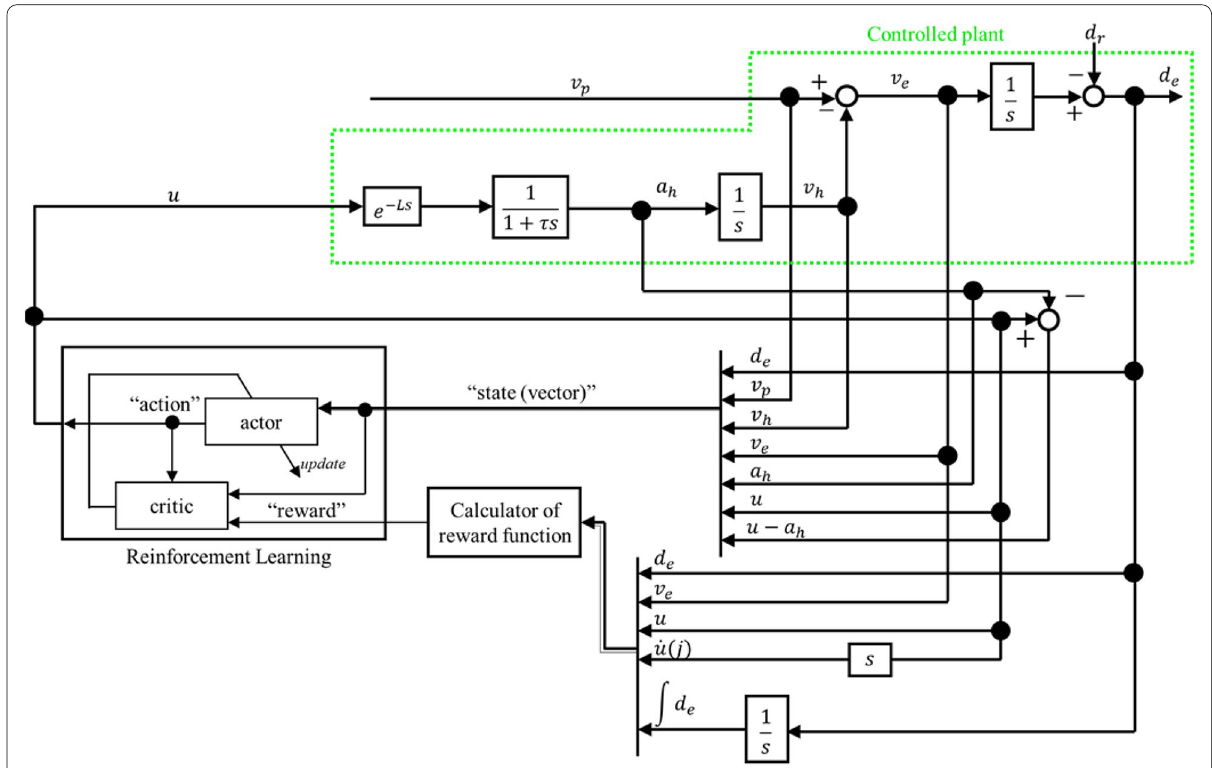
Fig. 2 Block diagram for an ACC system controlled by RL